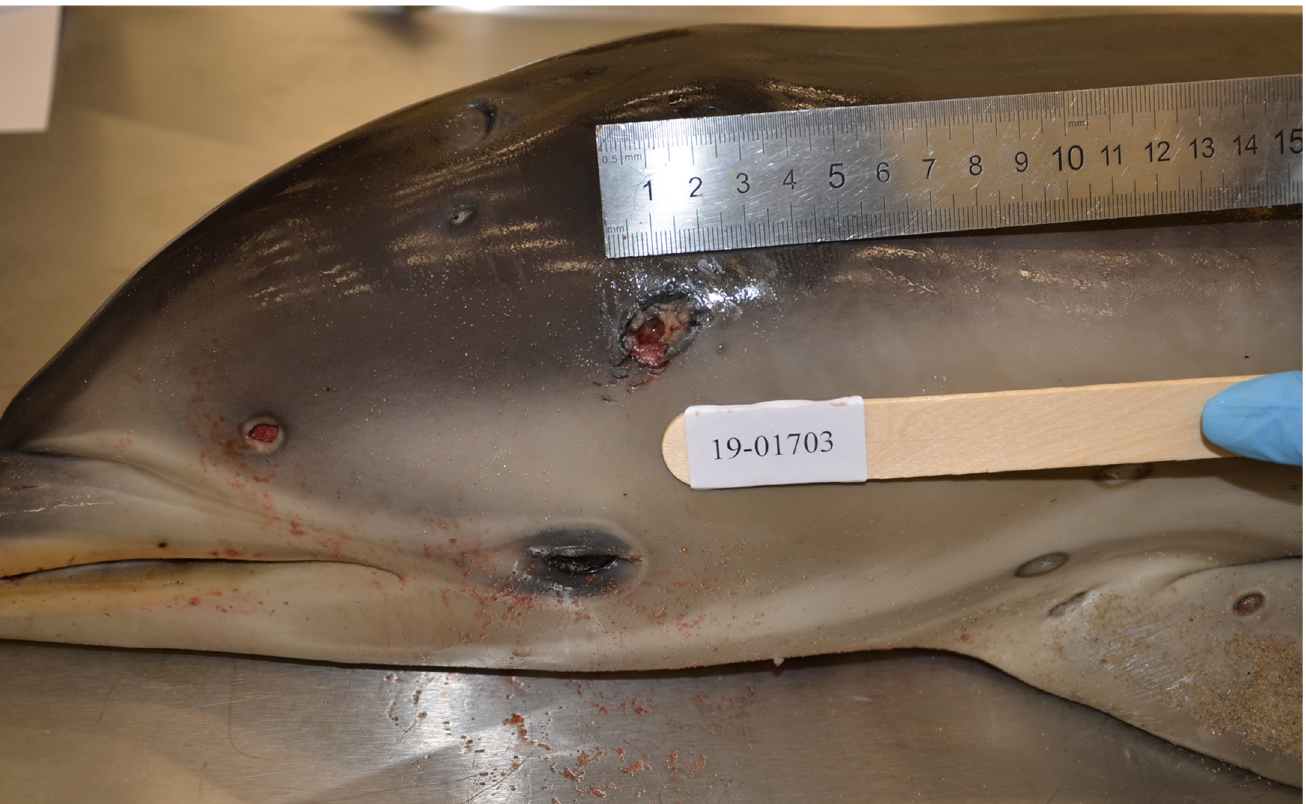
Figure 1. Female juvenile D. delphis . Multifocal non-raised deep irregular cutaneous ulcerations with necrotic centres which extend into the subcutis and blubber over the snout, lateral head, lateral body walls, and dorsal surface of the pectoral fins. The lesions vary in chronicity with variable depth and granulation tissue formation around wound edges, and range from 5 mm in diameter to 20 mm in diameter and up to 10 mm deep. Some lesions appear to be re-epithelialized/healed ulcers characterized by focal cutaneous depressions rimmed by a smooth edge of skin (dorsal and cranial to left pectoral